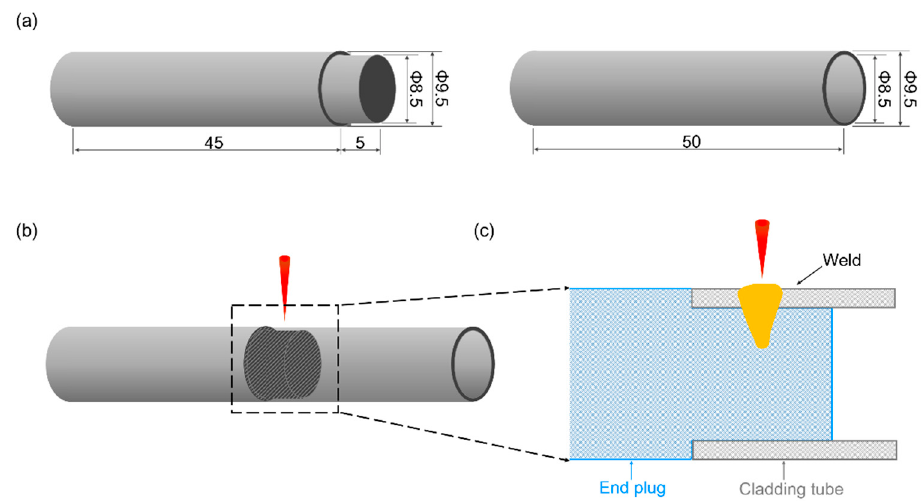
Figure 2. Schematics of: ( a ) dimensions of NS-Mo alloy cladding tube and end plug; ( b ) laser beam irradiation zone on the specimen during welding tests; ( c ) longitudinal section of the sample in the laser irradiation zone. (unit: mm).